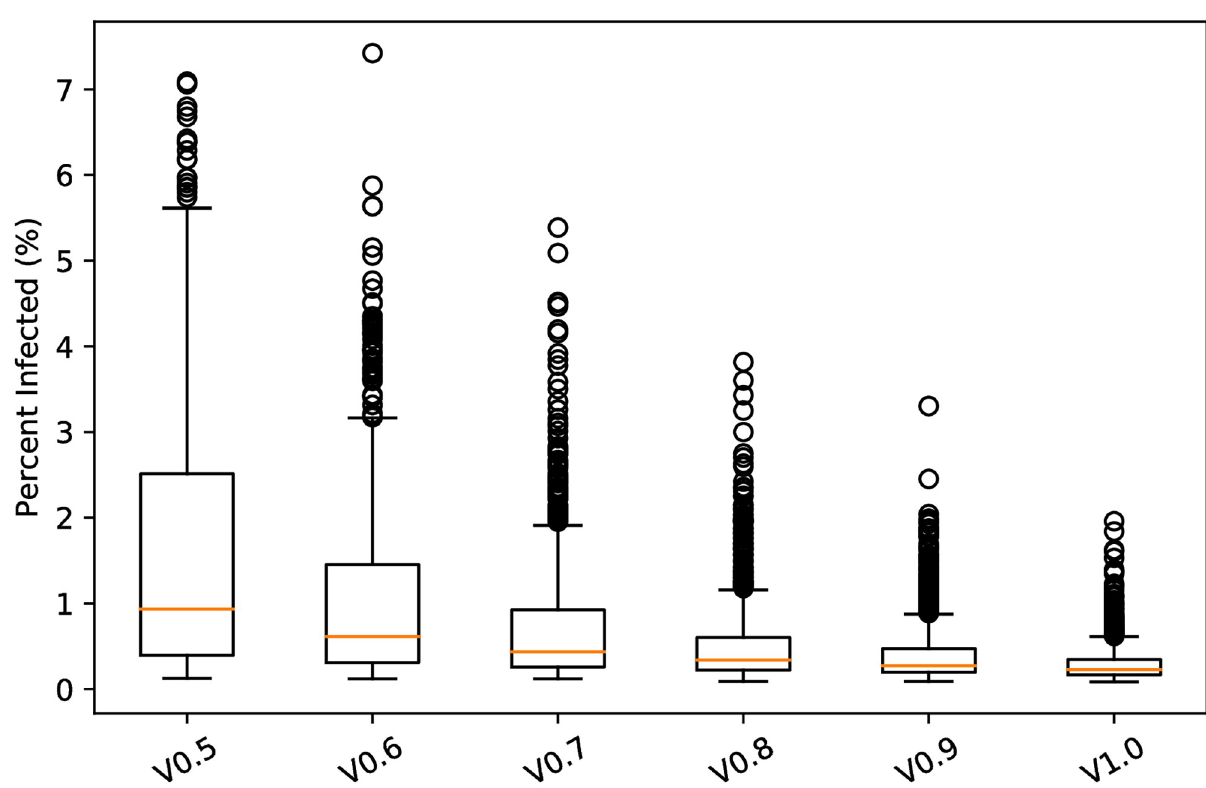
Fig 2. The percent of the population infected ( y -axis) in 1000 simulated 15-week semesters per scenario. Each scenario assumes that 50% vaccine effectiveness and considers different proportions V 2 {.5, .6, ... , 1} of the campus population vaccinated.